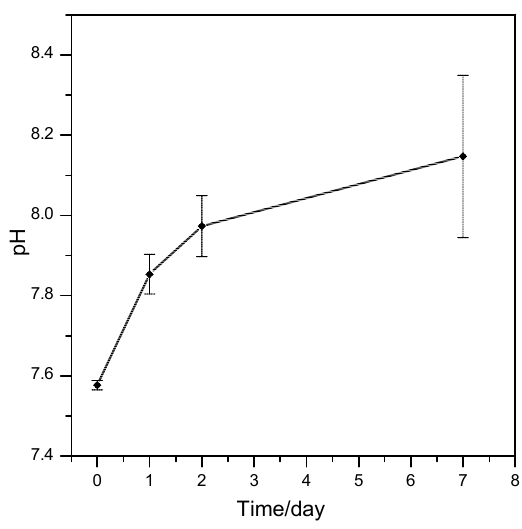
Figure 8. pH variation induced by the wollastonite-diopside glass-ceramic scaffolds over time. The MTT assay was performed in order to evaluate the viability of fibroblasts seeded onto W-D glass-ceramic foams for three and seven days. As shown in Figure 9, a significant increase in cell viability can be observed with culturing time, indicating the biocompatibility of the produced material. A similar trend in cell growth is evident in the control condition (TCP). This suggests that the viability of the fibroblasts was not affected by the formulation of the studied material.